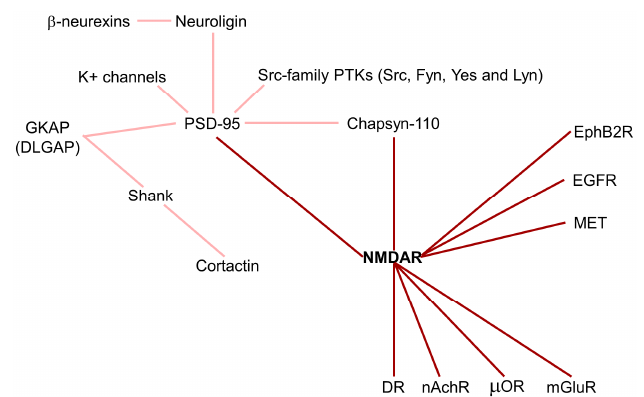
Figure 3. NMDA receptor interactome. NMDAR forms heterocomplexes with other proteins which determine receptor function and activated downstream signaling. Dark red line: direct NMDAR interactions; light red lines: indirect NMDAR interactions. DR: dopamine receptor; EGFR: epidermal growth factor receptor; EphB2R: ephrin receptor; GKAP: guanylate kinase-associated protein; mGluR: metabotropic glutamate receptor; nAchR: nicotinic acetylcholine receptors; PTK: protein-tyrosine kinase; µOR: opioid receptor.